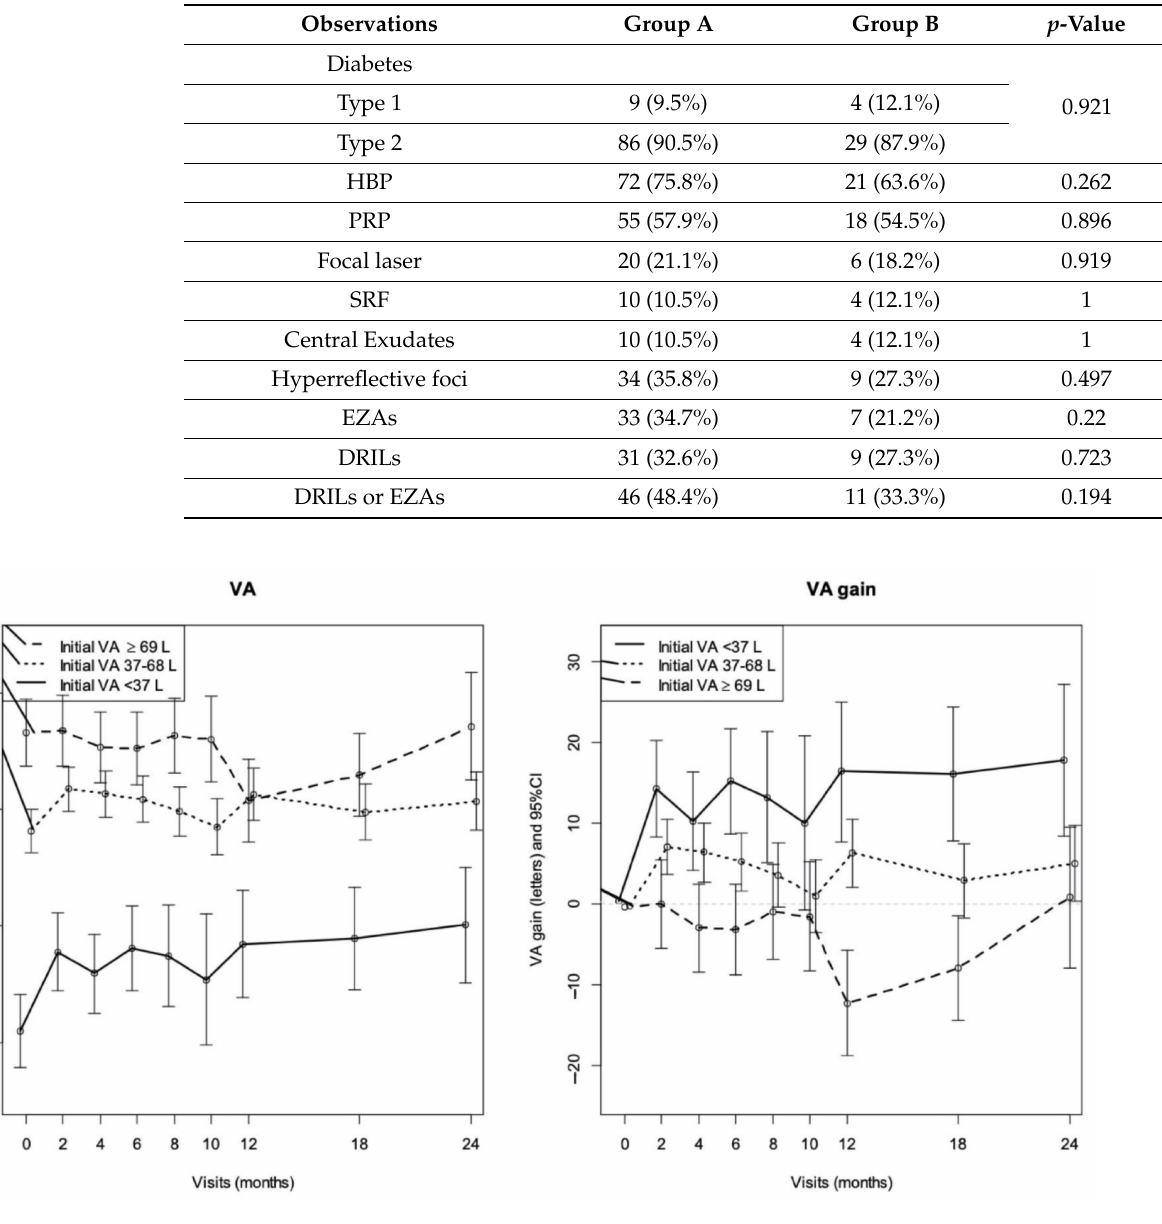
Figure 3. Changes in final VA and VA gain depending on baseline